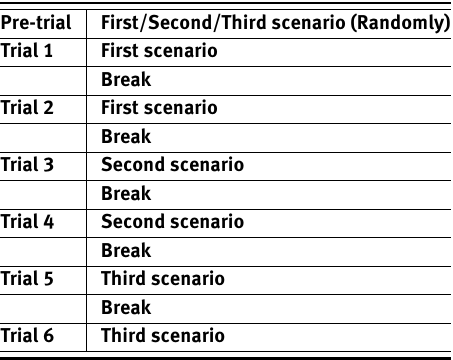
Table 4. Sequence of the virtual social situations (as they appear on the screen) and expected response by the participants